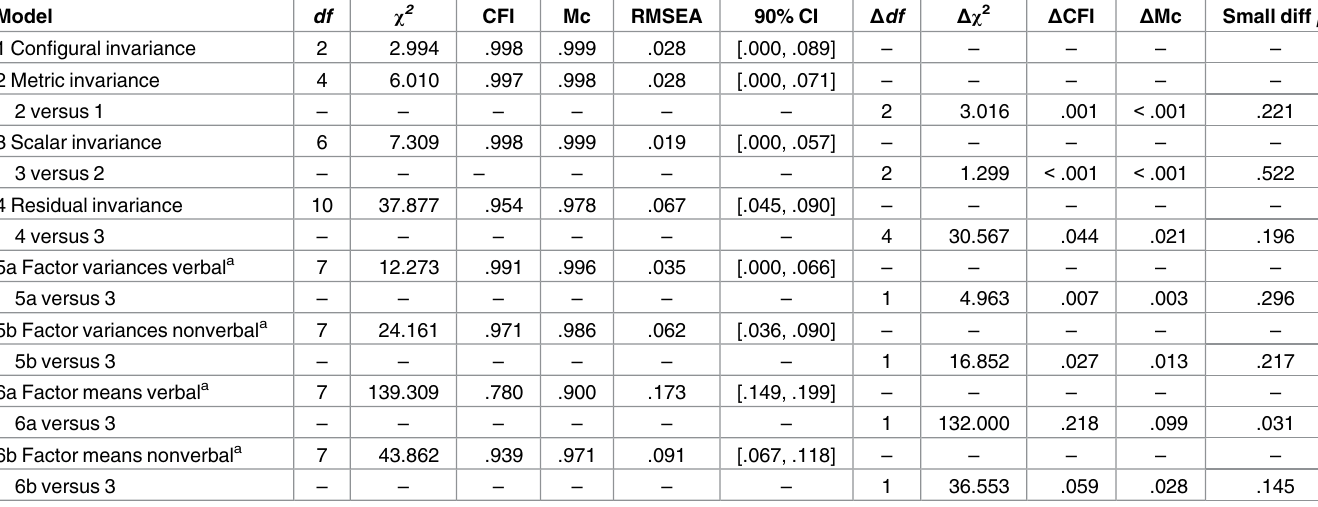
Table 3. Fit Indices for Multi-group Confirmatory Factor Analysis Evaluating Measurement Invariance of the Two-factor Structure Including the Four Intelligence Subtests Across Individuals With and Without a Migration Background.